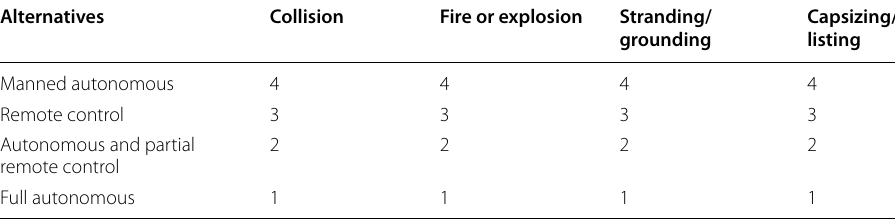
Table 6 Numerical decision matrix